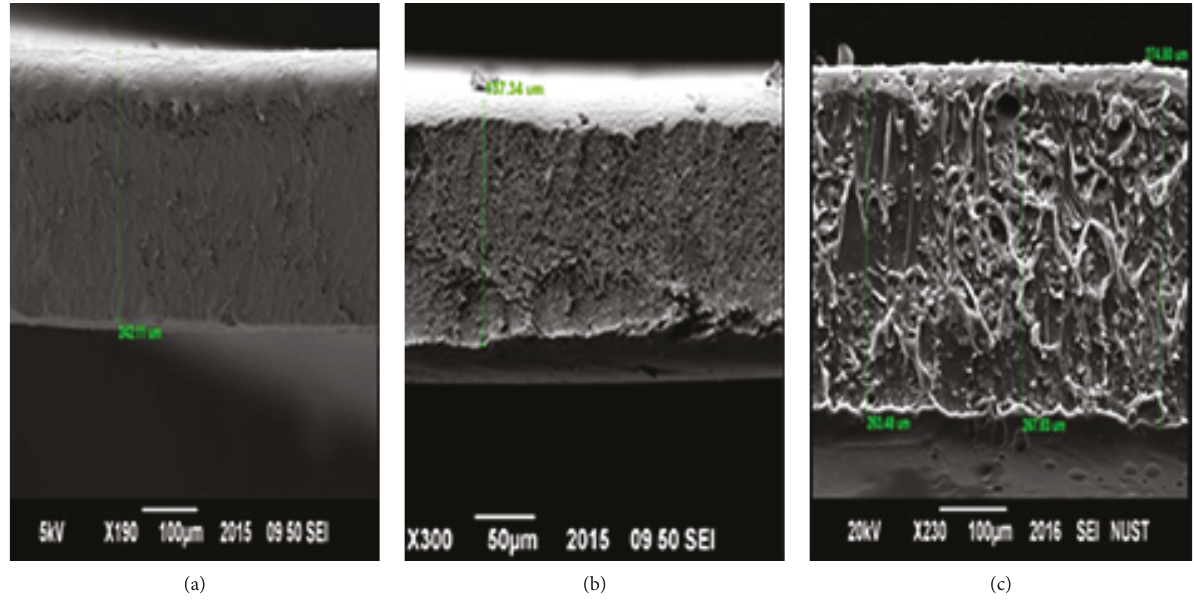
Figure 2: SEM micrographs representing the transverse view of the prepared hydrogels: (a) HG; (b) HGAA; (c)